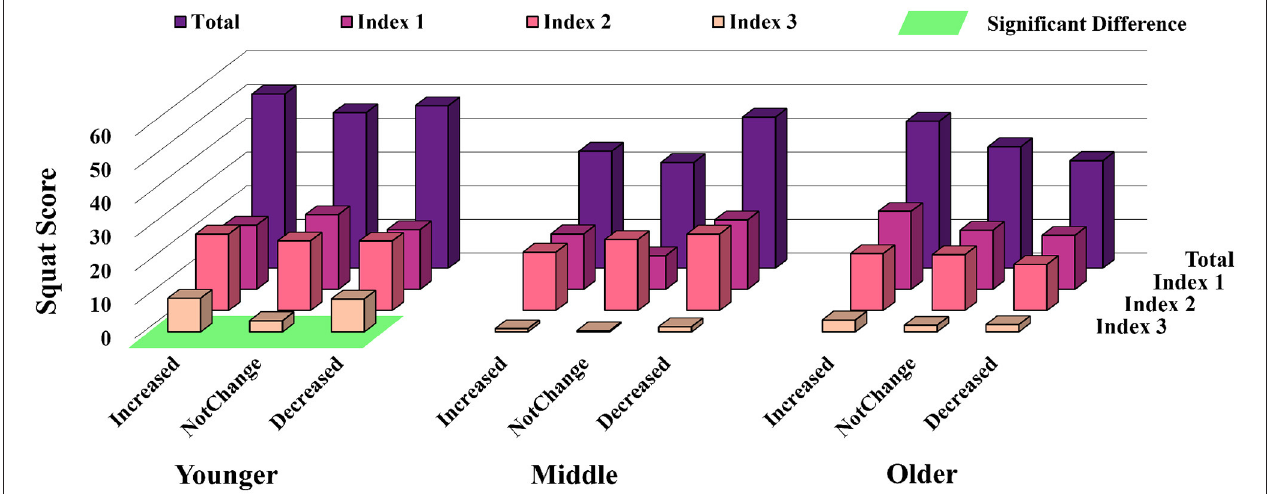
FIGURE 8 | Exercise changed and squat score among different